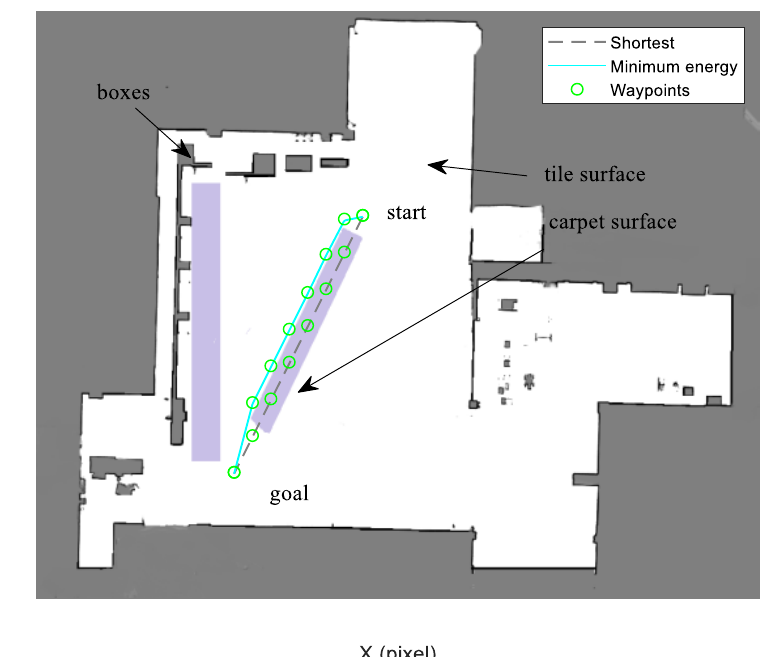
Figure 20. Optimal trajectory based on minimum energy.